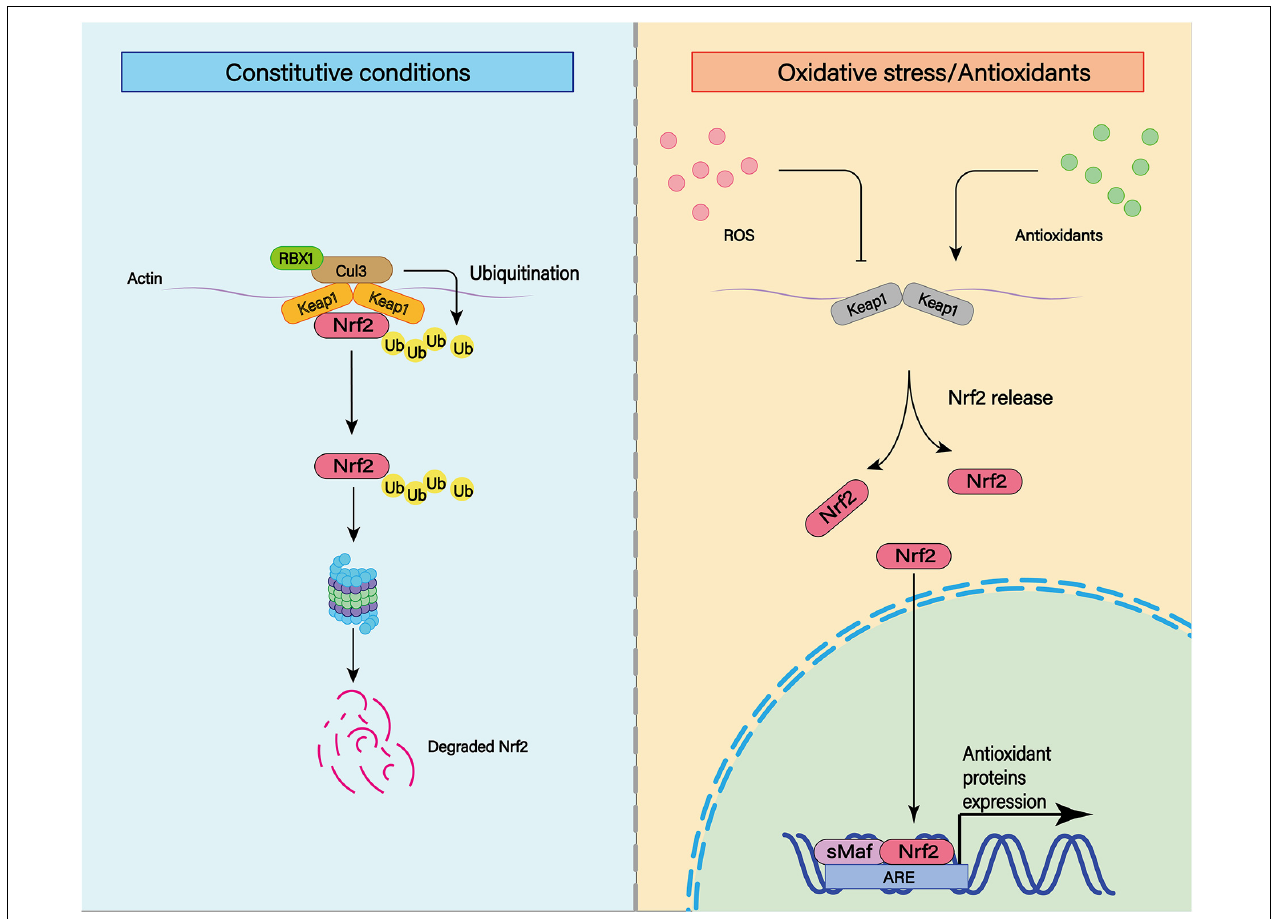
FIGURE 8 | The transcription factor nuclear factor erythroid-derived 2-like 2 (Nrf2) plays an important role in cellular antioxidant and other important physiological processes. Under physiological conditions, Nrf2 can be ubiquitinated and bind to Keap1. Subsequently, Nrf2 can be degraded by keAP1-dependent proteasome. In addition to ubiquitination, various post-translational modifications such as phosphorylation can affect the stability of Nrf2 structure. Under moderate oxidative stress and antioxidant stimulation, Nrf2 can enhance its stability through various post-translational modifications such as phosphorylation. At the same time, Nrf2 with enhanced stability can be translocated to the nucleus and combined with the cis-acting element ARE to activate the transcription of antioxidant